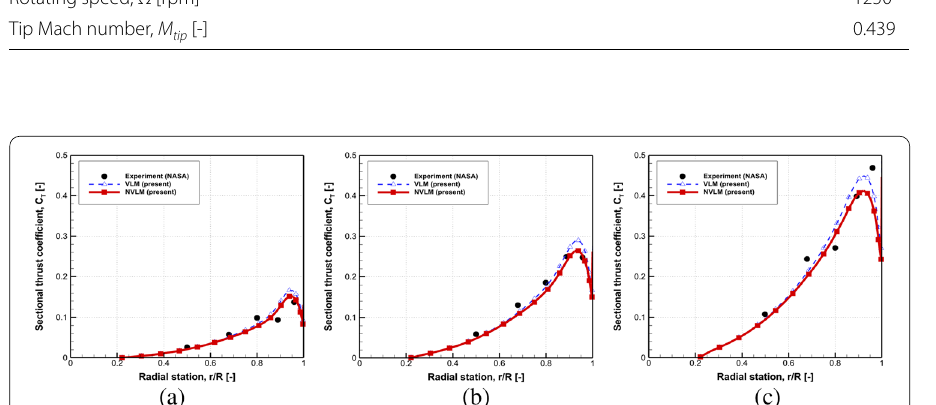
5º, ( b ) θ c 8º, and ( c ) θ c = = =